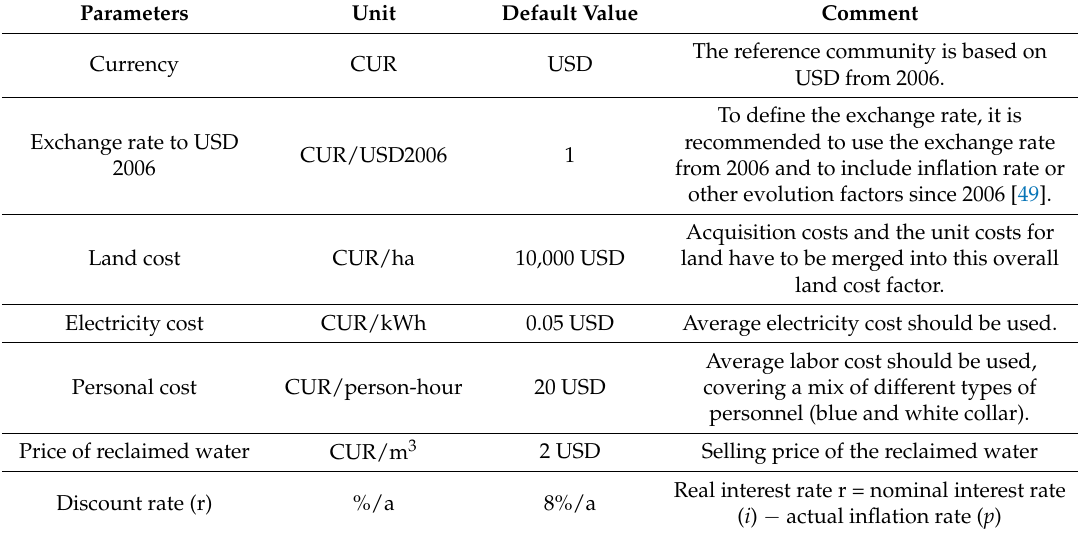
Table 7. Parameters considered in the community profiles for the calculation of the cost component. Parameters Unit Default Value